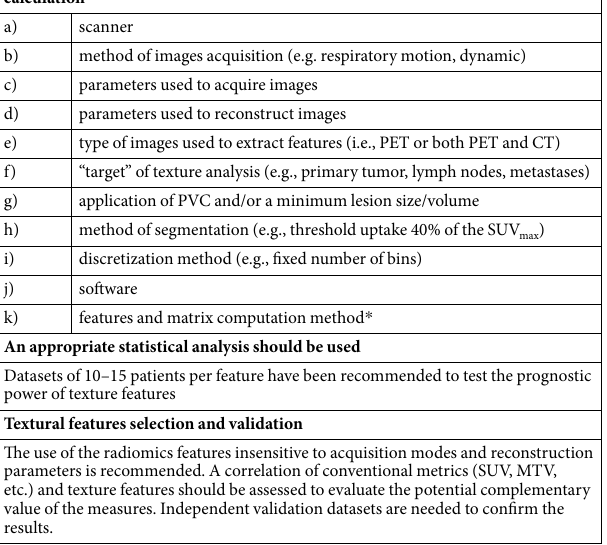
Table 4. Summary of relevant methodological issues in calculating and reporting FDG-PET/CT texture analysis. * A proposal for a consistent terminology is reported within the Supplementary